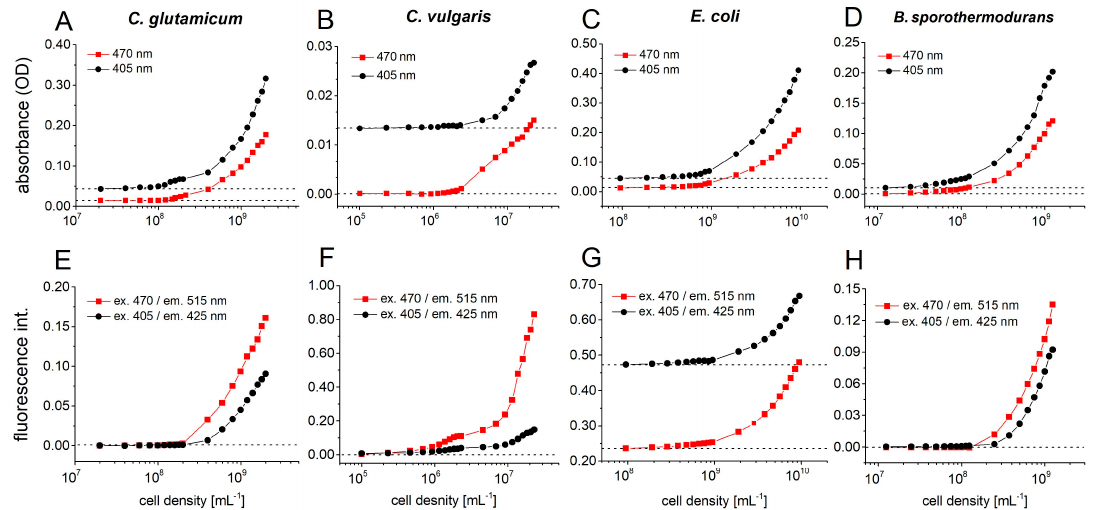
Figure 10. Sensor calibration for di ff erent microbial cultures cell density. The dependence of absorbance and autofluorescence intensity on inoculum cell density was recorded for di ff erent microorganisms. The signals were calculated as mean value of 30 droplets with an average size of 440 nL, using the multi-channel photo-fluorimeter device configuration: absorbance at 470 nm and 405 nm, fluorescence channels: ex. 470 / em. 515 nm and ex. 405 / em. 425 nm; ( A ) Absorbance of C. glutamicum ; ( B) absorbance of C. vulgaris , ( C ) absorbance of E. coli RV308 , ( D ) absorbance of B. sporothermodurans PL01, ( E ) autofluorescence of C. glutamicum , ( F ) autofluorescence of C. vulgaris , ( G ) autofluorescence of E. coli RV308 , ( H ) autofluorescence of B. sporothermodurans PL01.